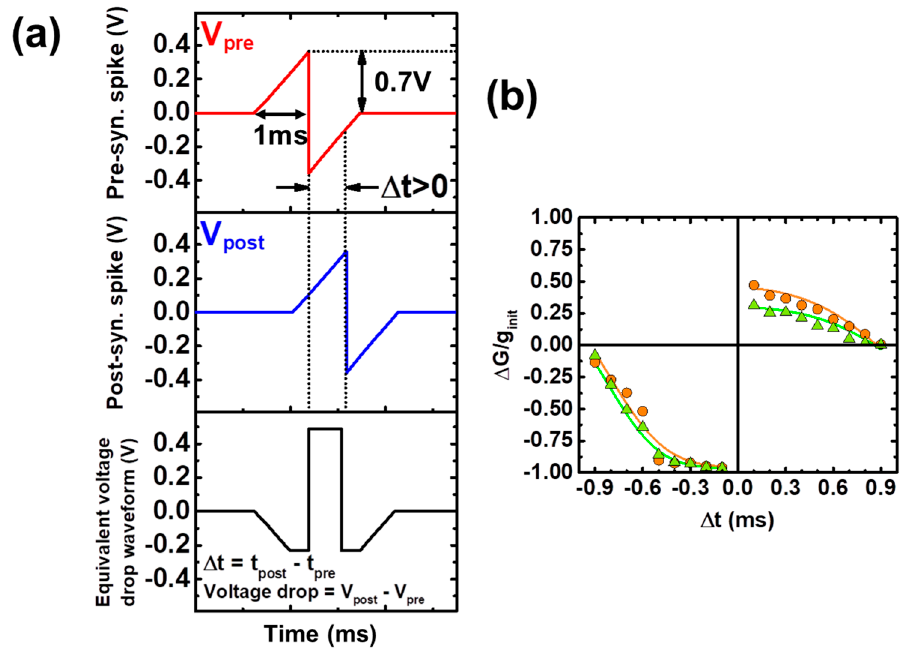
Figure 7. ( a ) Identical pre (red) and post-synaptic (blue) waveforms are applied to the tested samples, which result in an equivalent voltage drop waveform (black) showing a dependence on the time delay ∆ t. ( b ) Experimental [33] (dots) and modeled (line) STDP functions.